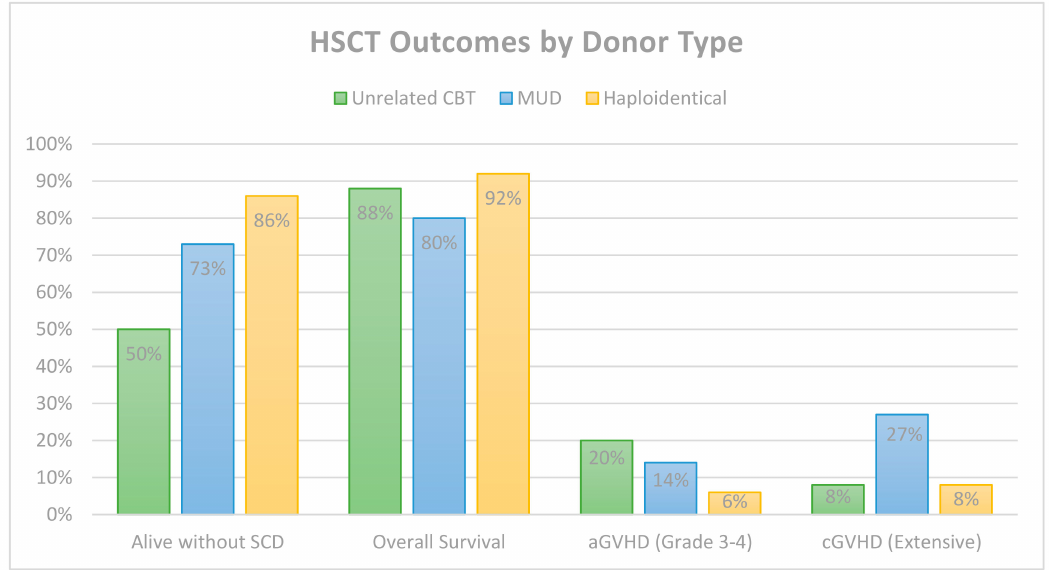
Figure 1. Comparative HSCT outcomes. n = 50 for unrelated CBT, n = 44 for MUD and n = 100 for haploidentical. HSCT, hematopoietic stem cell transplant; SCD, sickle cell disease; aGVHD, acute graft versus host disease; cGHVD, chronic graft versus host disease; CBT, cord blood transplant; and MUD, matched unrelated